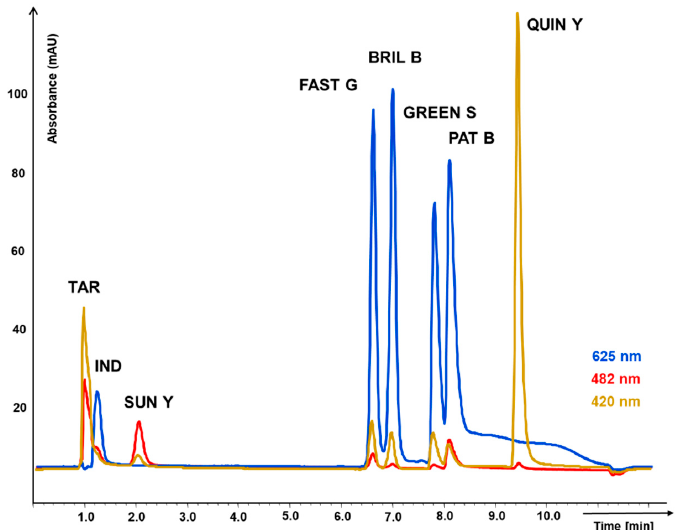
Figure 1. Chromatogram of 8 food synthetic dyes separation on monolithic column Chromolith Performance CN 100 × 4.6 mm with guard column Chromolith CN 5 × 4.6 mm. Gradient elution with mobile phase comprising of (A) methanol and (B) water solution of 2% acetic acid (pH 7.0). Detection